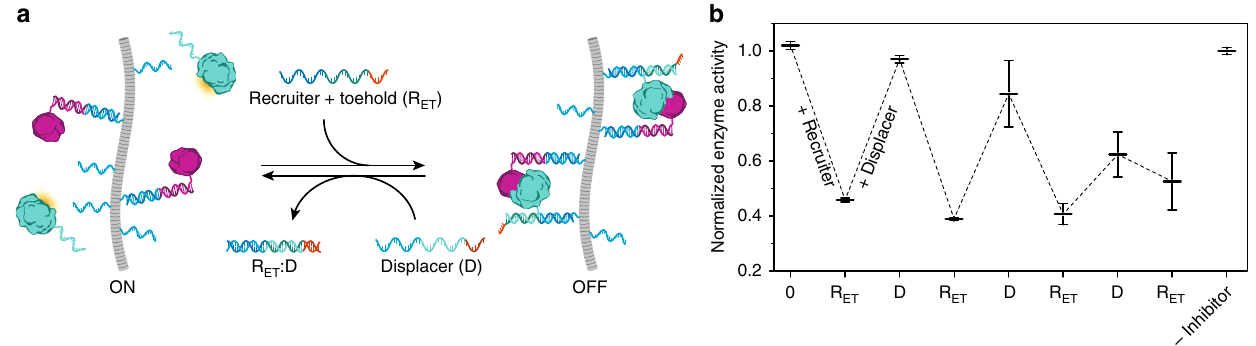
Fig. 5 Reversible control of enzyme recruitment via DNA strand exchange. a The enzyme is recruited to polymers pre-assembled with inhibitor protein by the addition of recruiter strand R ET . A 10-nucleotide overhang (toehold) appended to the recruiter strand (R ET ) allows its displacement by a fully complementary displacer strand (D) via toehold-mediated strand displacement. b Normalized enzyme activity upon the sequential addition of recruiter and displacer oligonucleotides. Each iteration, a twofold molar excess of either recruiter or displacer strand is added with respect to the previous stage. Enzyme activities were normalized to a control without inhibitor protein. Experiments were performed using 25% BTA-DNA (0.5 μ M BTA-DNA, 1.5 μ M